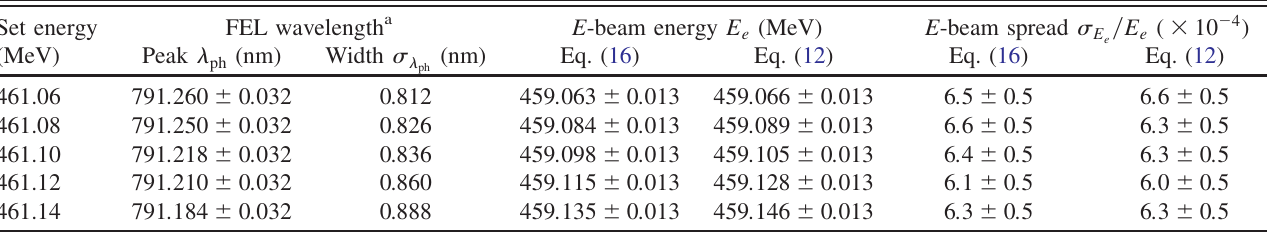
TABLE I. Comparison of the electron beam energy and energy spread determined using both Eq. (16) and Eq. (12) for a collimation aperture of 12.7 mm radius. The uncertainty shown in the table represents the overall uncertainty of the measurement. Set energy FEL wavelength a E -beam energy E